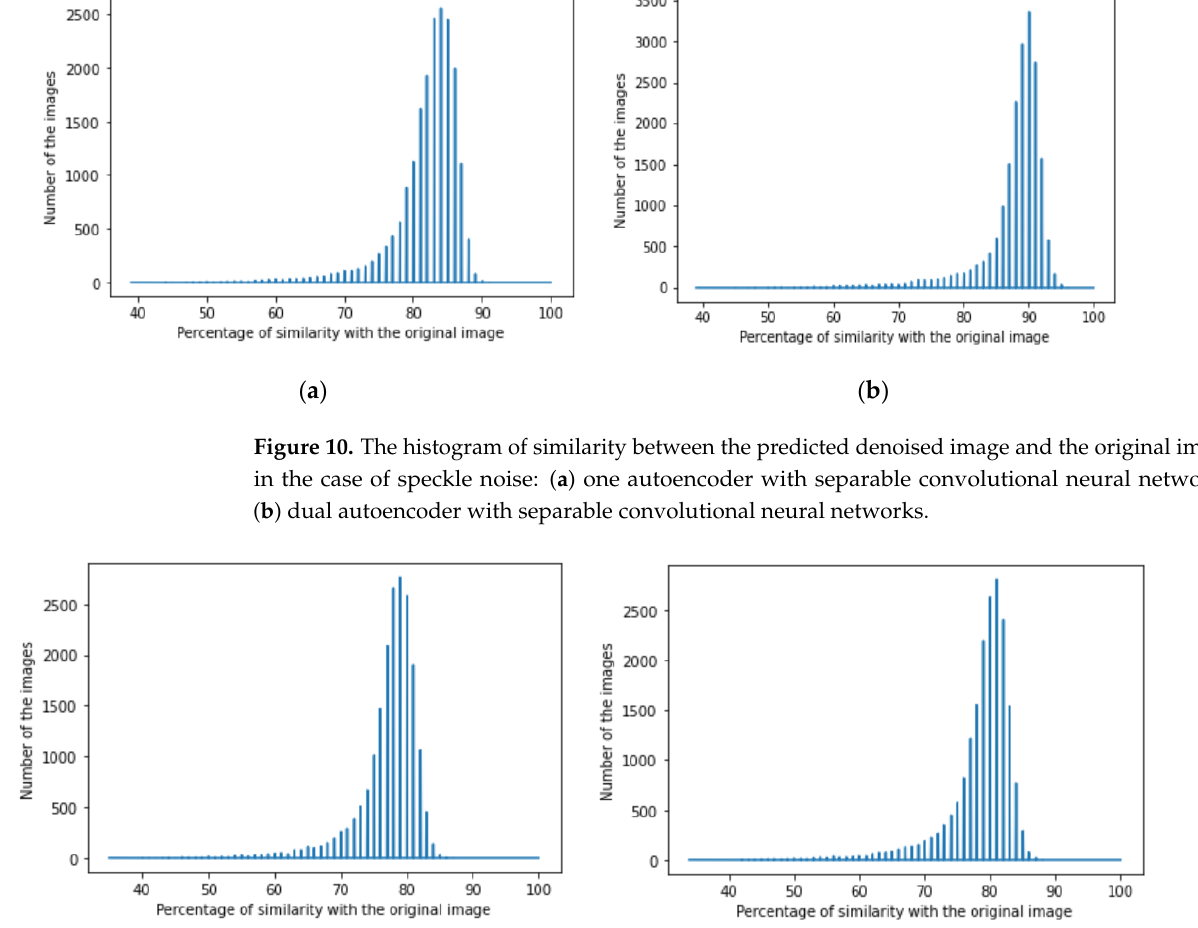
Figure 9. The histogram of similarity between the predicted denoised image and the original image in the case of speckle noise: ( a ) one autoencoder with convolutional neural networks; ( b ) dual auto- encoder with convolutional neural networks.